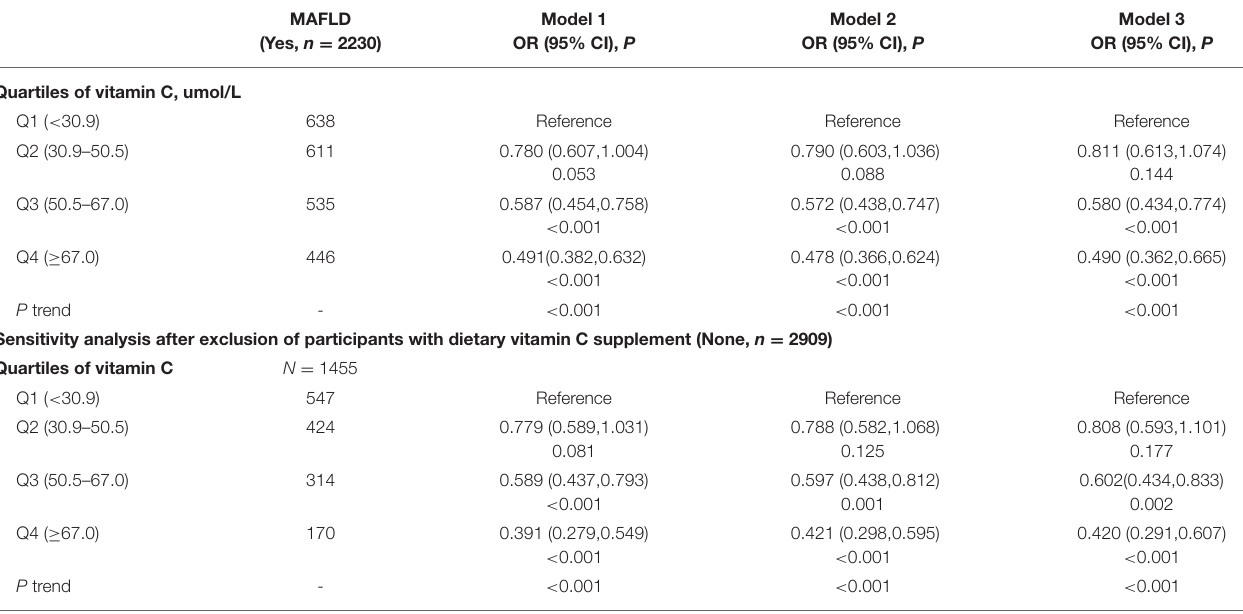
Model 1 OR (95% CI), P